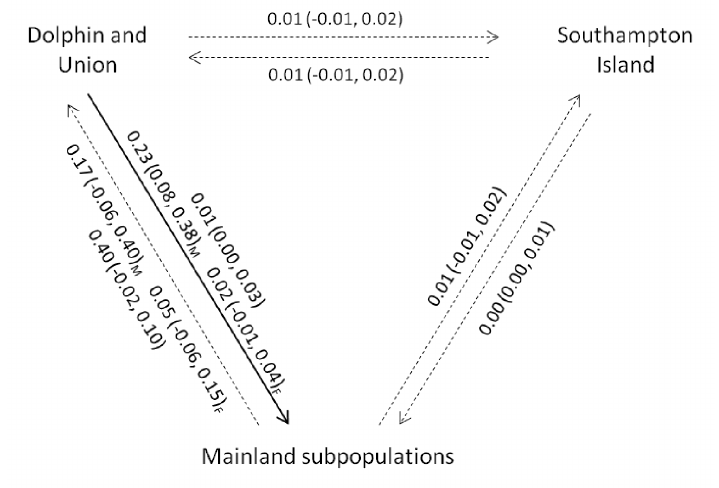
Figure 5. Contemporary gene flow rates (m) between the mainland and island subpopulations. 95% confi- dence intervals are in parentheses. Dashed arrows indicate values that do not significantly differ from zero based on 95% confidence intervals. Mainland subpopulations include BE and QAM for males (indicated by the subscript ‘M’), and BE, BAT, QAM and BEV/AH for females (indicated by the subscript ‘F’). Es- timates into and out of Southampton Island include both males and females, as no sex information was available for SH. Male migrants were a mixture of first- and second-generation